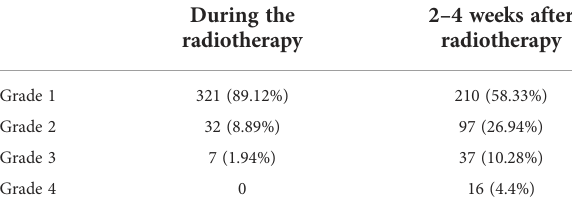
TABLE 5 Skin toxicity during and after 2 – 4 weeks of